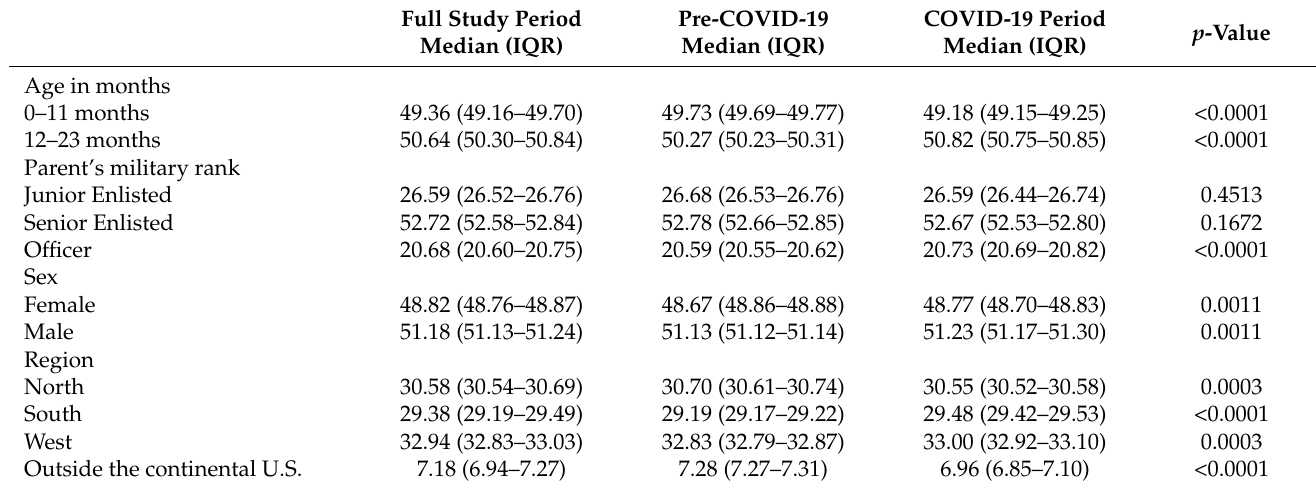
Table 1. Population demographics as the median monthly percent of population within each demo- graphic group.